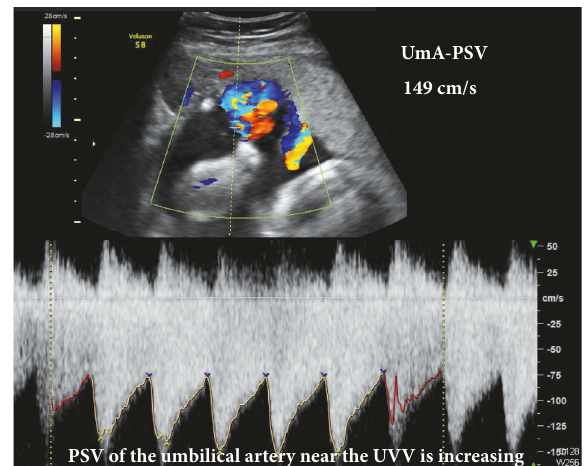
Figure 3: Ultrasonographic echocardiogram at 32 weeks of ges- tation shows edematous enlargement of the umbilical vein varix and an increase of the peak systolic velocity of the umbilical artery (UmA-PSV) up to 149